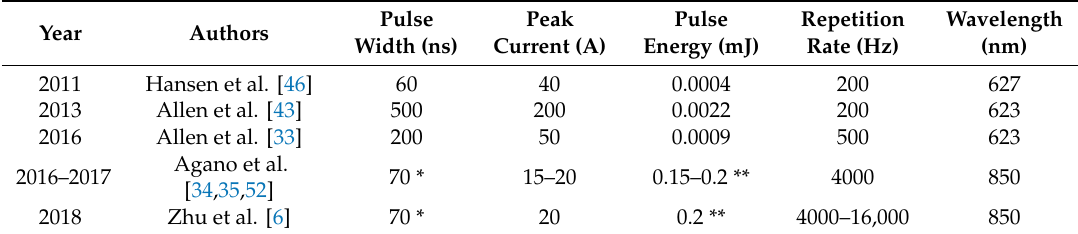
Table 2. Summary of the Fundamental development of LED-based PAI